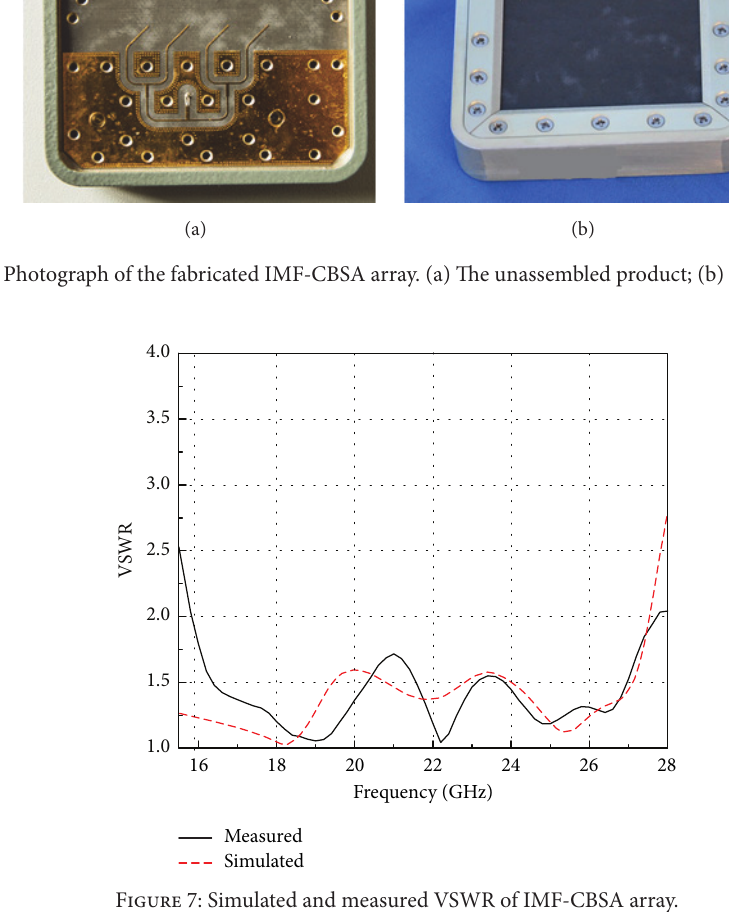
Figure 7: Simulated and measured VSWR of IMF-CBSA array.